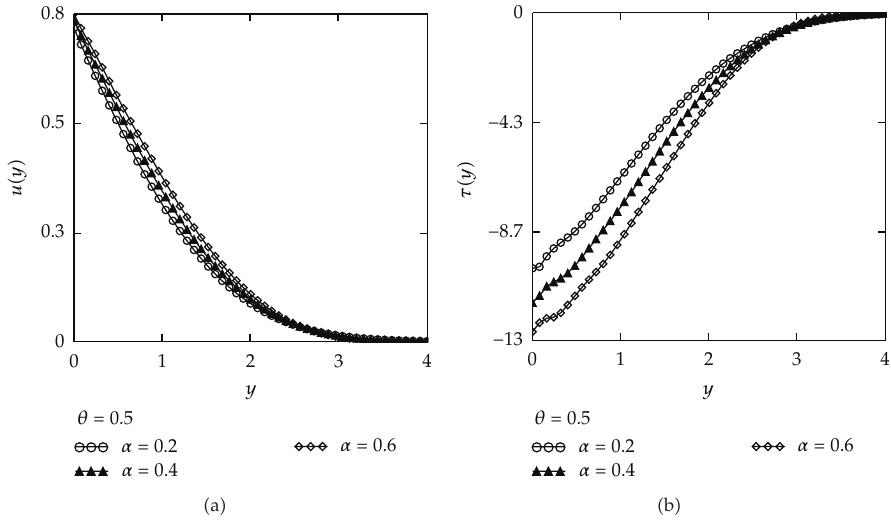
Figure 7: Profiles of the velocity field u (cid:4) y,t (cid:5) and the shear stress τ (cid:4) y,t (cid:5) for fractional Maxwell fluid given by (cid:4) 4.7 (cid:5) and (cid:4) 4.15 (cid:5) , for U (cid:9) 1, y (cid:9) 1, ν (cid:9) 0 . 379, μ (cid:9) 33, λ (cid:9) 1 . 5, θ (cid:9) 0 . 5, t (cid:9) 5s, and di ff erent values of α